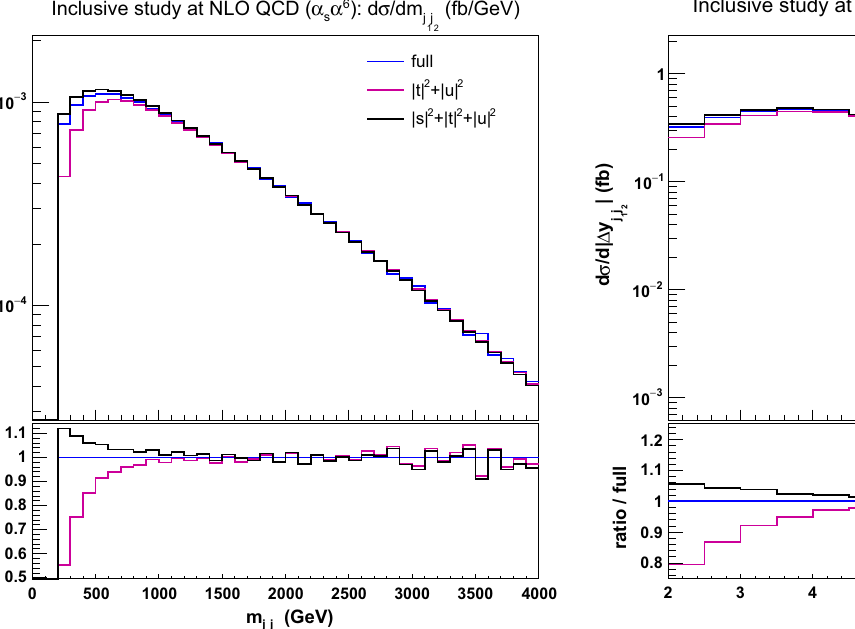
Fig. 6 Differential distributions in the di-jet invariant mass (left) and the rapidity separation (right) of the two tagging jets at NLO QCD i.e. at order O (α s α 6 ) for the full computation and two approximations. The upper plots provide the absolute value for each prediction while the